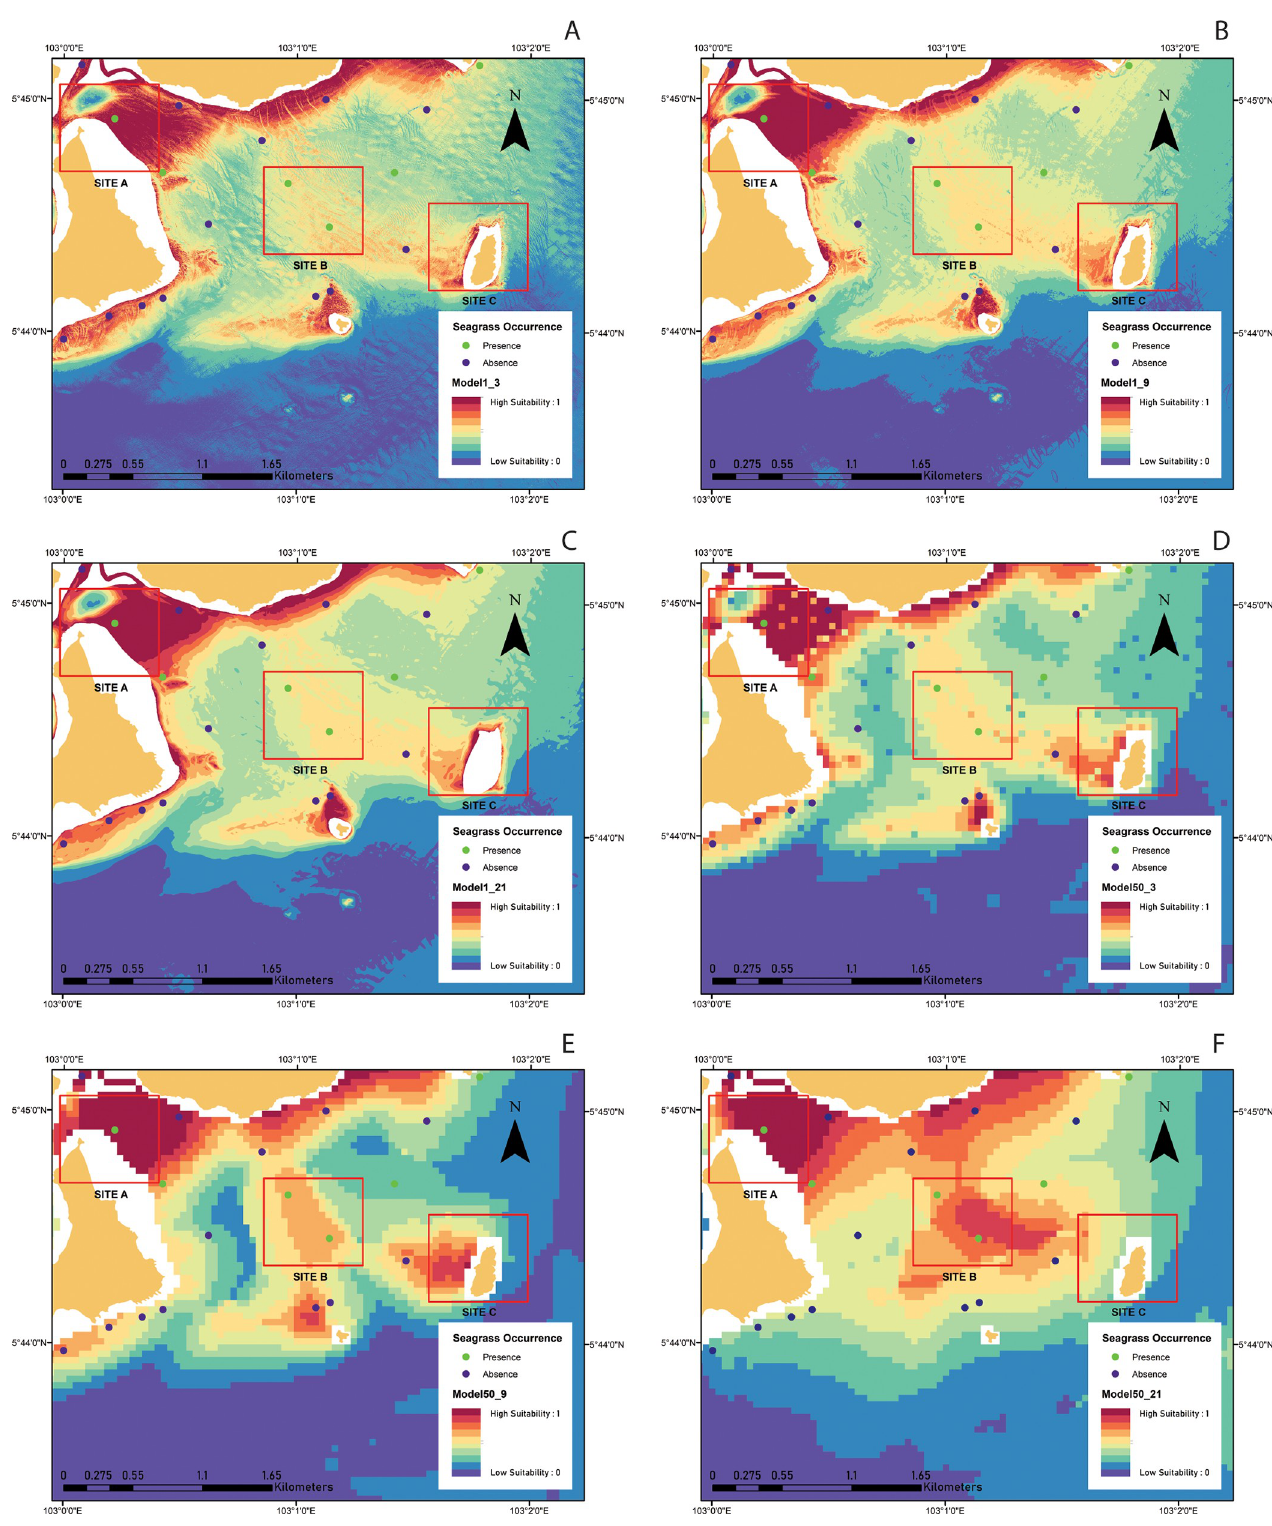
Fig 6. Model predictions of the suitability of seagrass habitat zoomed into three sites within the east-south area. Site A–northern area of Pulau Pinang; Site B–Cina Terjun cape; Site C–Pulau Ekor Tebu. The suitability index ranges from 1 (high suitability) to 0 (low suitability), while for spatial resolution and scale, (A) 1 m (n = 3), (B) 1 m (n = 9), (C) 1 m (n = 21), (D) 50 m (n = 3), (E) 50 m (n = 9), (F) 50 m (n = 21), respectively.